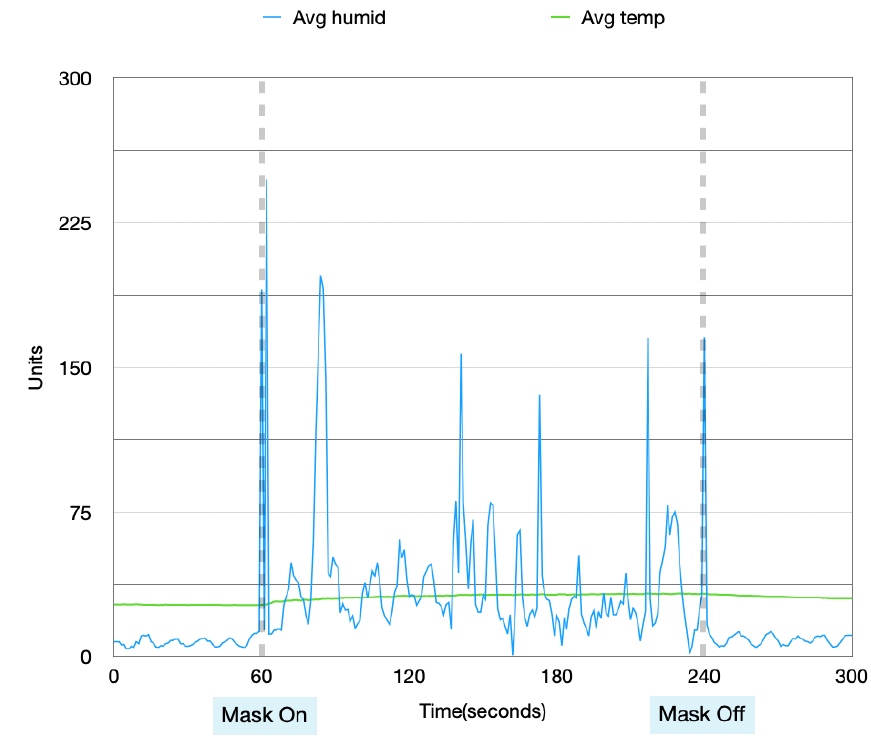
Figure 6. Data collected during the day, with prior physical activity.